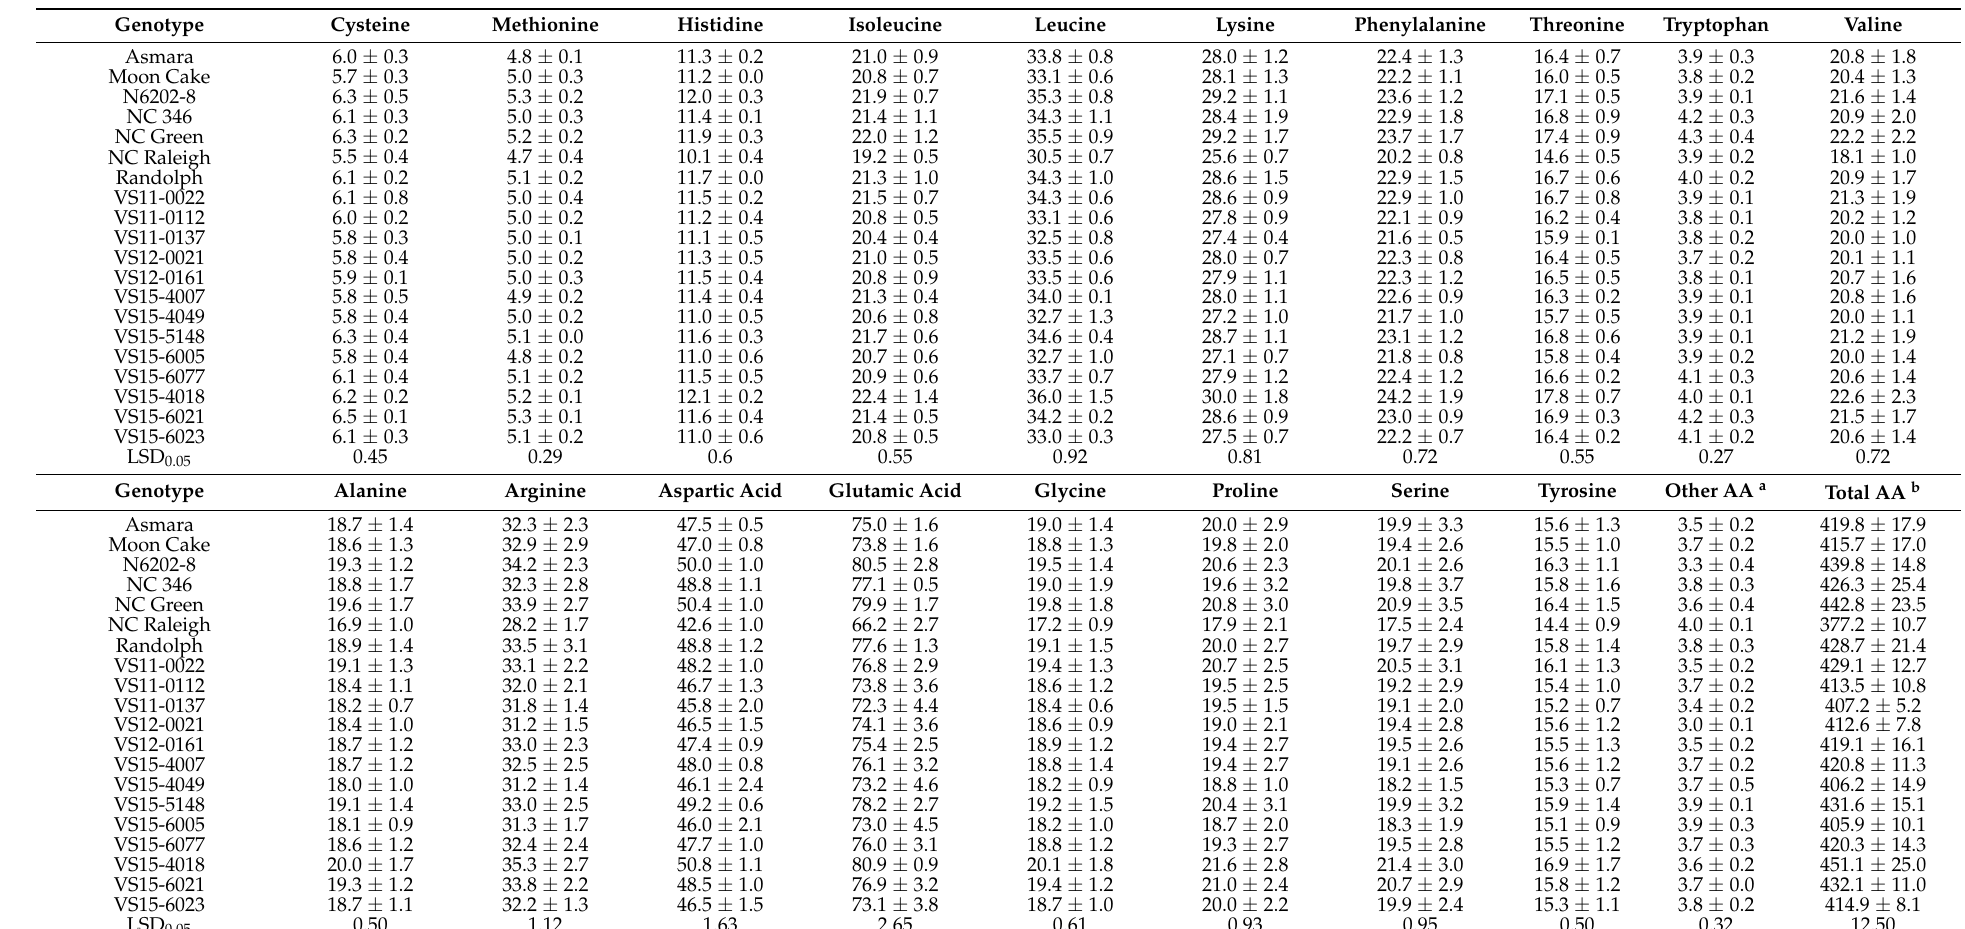
Table 7. Average performance of 20 soybean cultivars and lines in seed amino acids (mg g − 1 on dry weight basis) at edamame or R6 stage with whole samples dried by low-heat drying across three years